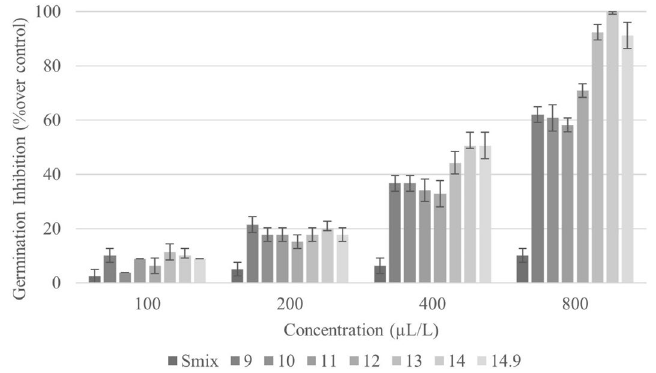
Figure 4. Inhibitory effect of CEO nanoemulsions with different HLB values on seed germination of E. crus- galli . Error bars represent standard deviation of the